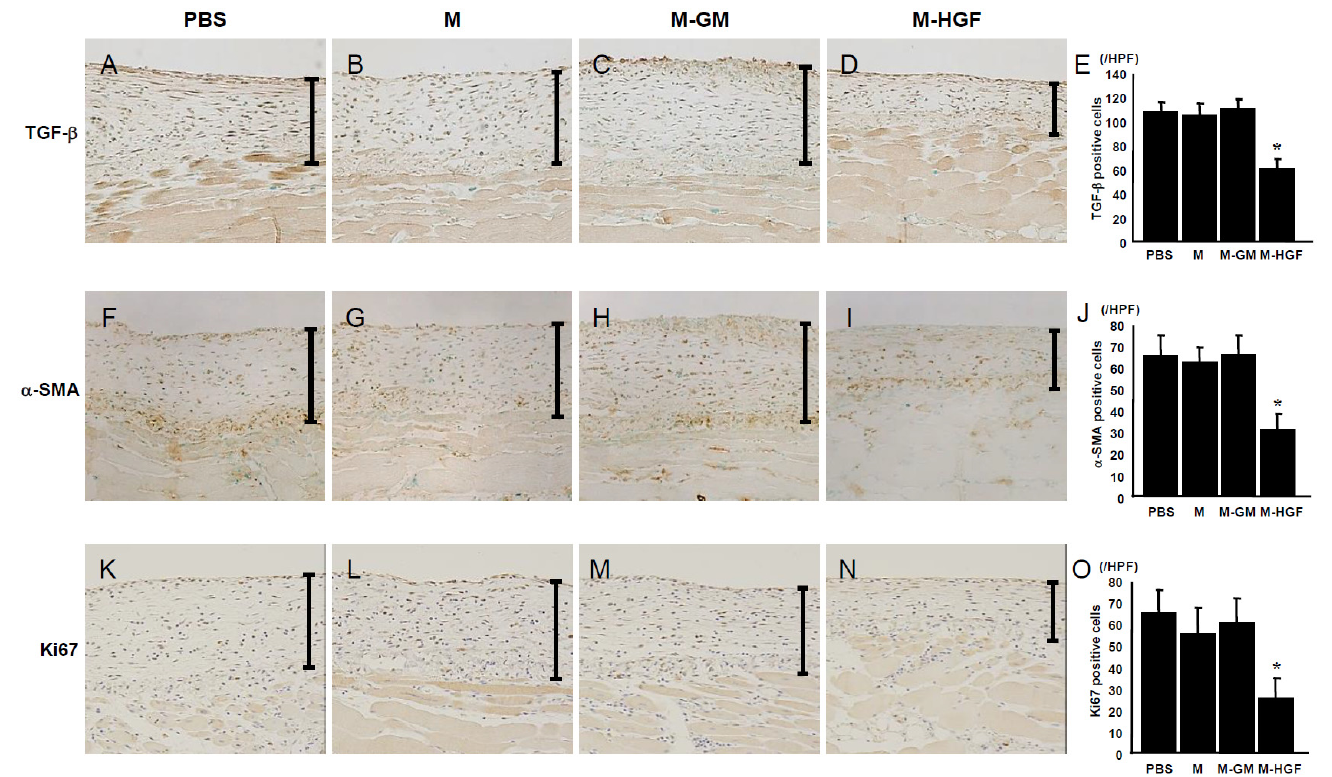
Figure 3. Immunohistochemistry findings for transforming growth factor-beta (TGF- β ), alpha- smooth muscle actin ( α -SMA), and Ki67. In the PBS group ( A , F ), the number of TGF- β -and α SMA- positive cells markedly increased in the thickened submesothelial compact zone at 21 days, while the proliferation of TGF- β -and α -SMA-positive cells in the submesothelial compact zone decreased in the M-HGF group at 21 days ( D , I ). In the M group ( B , G ) and M-GM group ( C , H ), the number of TGF- β -and α -SMA-positive cells markedly increased in the thickened submesothelial compact zone at 21 days, similar to that in the PBS group. The bar graph shows the number of TGF- β -and α -SMA-positive cells ( E , J ). In addition, the number of Ki67-positive cells significantly decreased in the fibrotic peritoneum of the M-HGF group ( N ) compared with those of the PBS ( K ), M ( L ), and M-GM ( M ) groups. The bar graph shows the number of Ki67-positive cells ( O ). * denotes a significant difference compared with the PBS group at p < 0.05. The bars indicate the thickness of the submesothelial compact zone; magnification, 200 ×